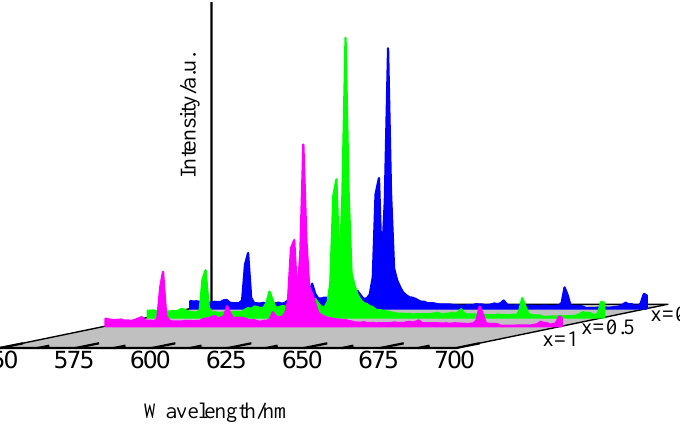
Figure 8. The emission spectrum of Sr 0.99 Mo x W 1 − x O 4 :0.01Eu 3+ (x = 0, 0.5, 1). Figure 9a depicts the emission spectra of SrMo 0.5 W 0.5 O 4 :Eu 3+ with varying Eu 3+ concentrations excited at 273 nm. Figure 9a shows that all samples’ peak forms and positions remain constant. However, with the Eu 3+ concentration increasing, the lumi- nescence intensity first increases and then decreases. The emission peak intensity of Sr 0.99 Mo 0.5 W 0.5 O 4 :0.01Eu 3+ achieves its maximum when the doping concentration of Eu 3+ is 1%, and if the concentration of Eu 3+ continues to increase, the phenomenon of con- centration quenching appears. This is because although the transition of emitted light increases with the increase of the Eu 3+ concentration, which can effectively improve the intensity of the emitted light, the continuous increase of the doping amount of Eu 3+ will narrow the distance between Eu 3+ , resulting in a decrease in emission intensity due to nonradiative energy transfer between Eu 3+ . To look into the energy transfer of Eu 3+ ions in SrMo 0.5 W 0.5 O 4 , the critical distance of Eu 3+ ions is first estimated using the formula below.